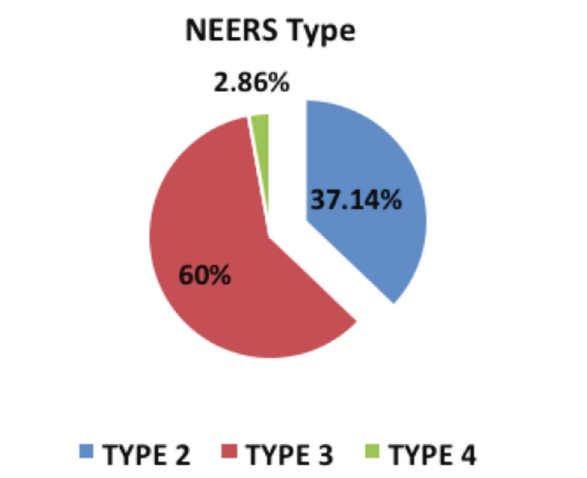
Distribution of the Neers pattern in the study population. Fig. 3: